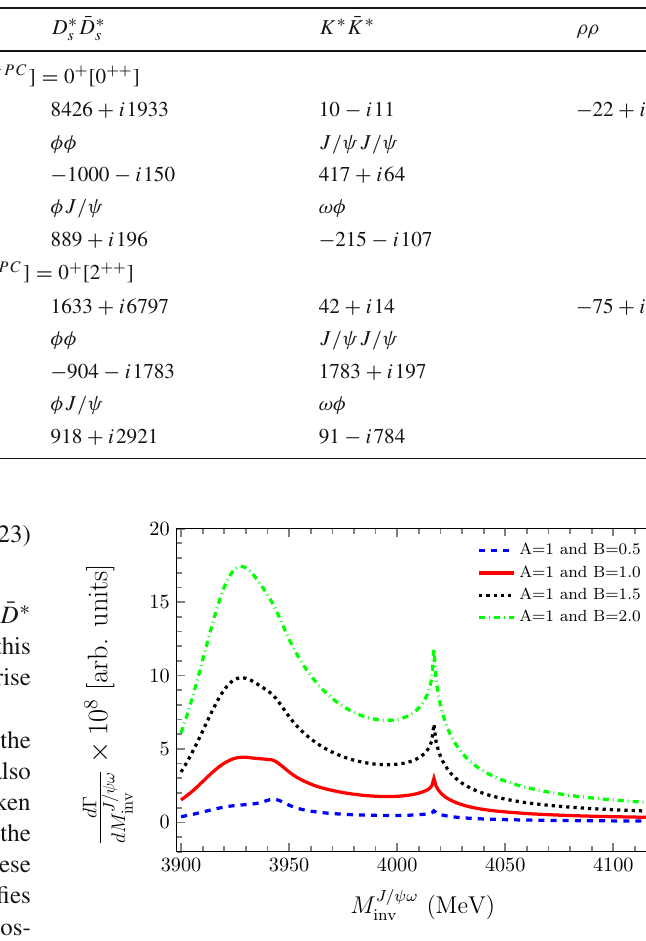
Fig. 5 d (cid:8) results for the different values of the parameter B dM J /ψω inv